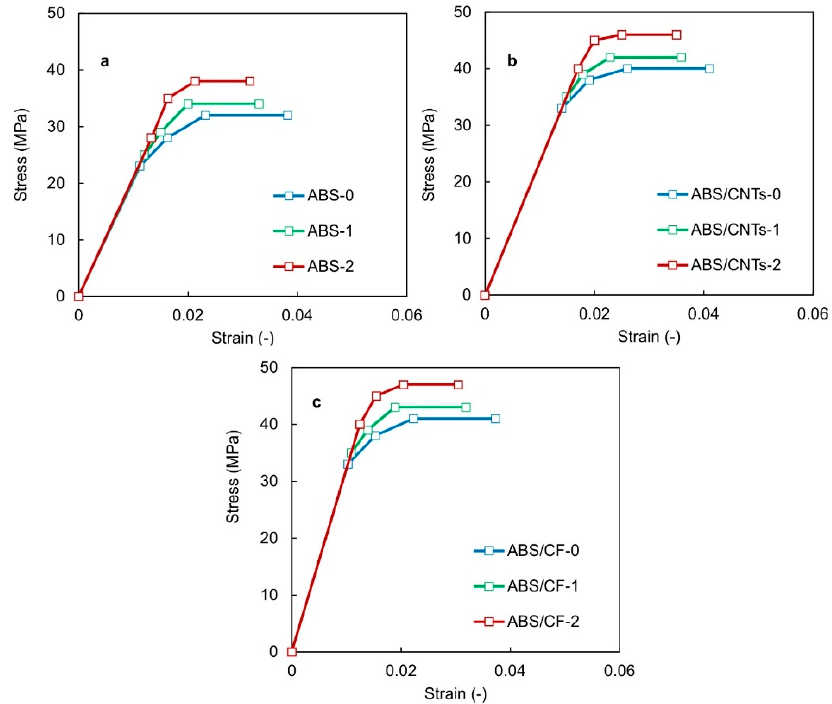
Figure 9. Finite element analysis (FEA) generated stress-strain curves of different levels of hierarchy for ( a ) ABS, ( b ) ABS/CNT and ( c ) ABS/CF materials.